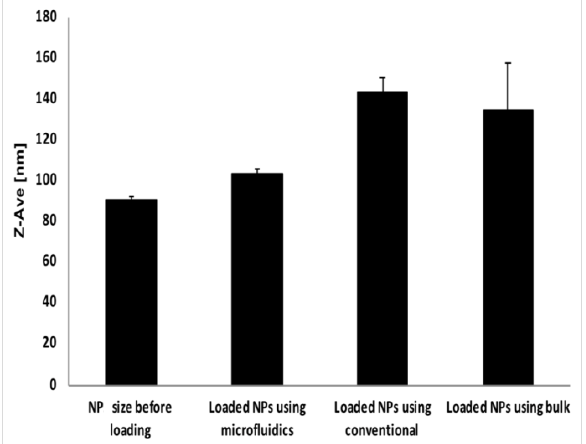
Figure 9: Comparison of the NP size after encapsulation using differ- ent approaches, namely the microfluidic system and two benchtop pro- cedures.